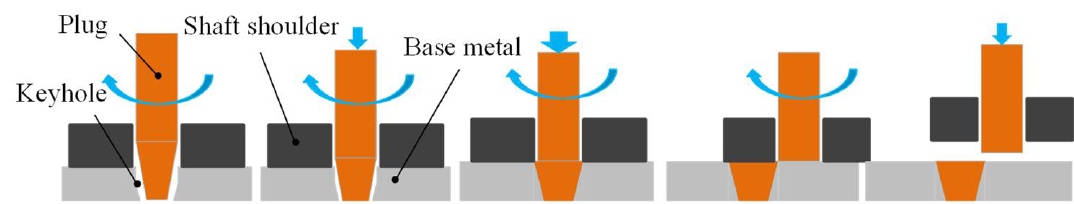
Figure 1. Schematic diagram of the friction plug repair welding process by shaft shoulder auxiliary heating.